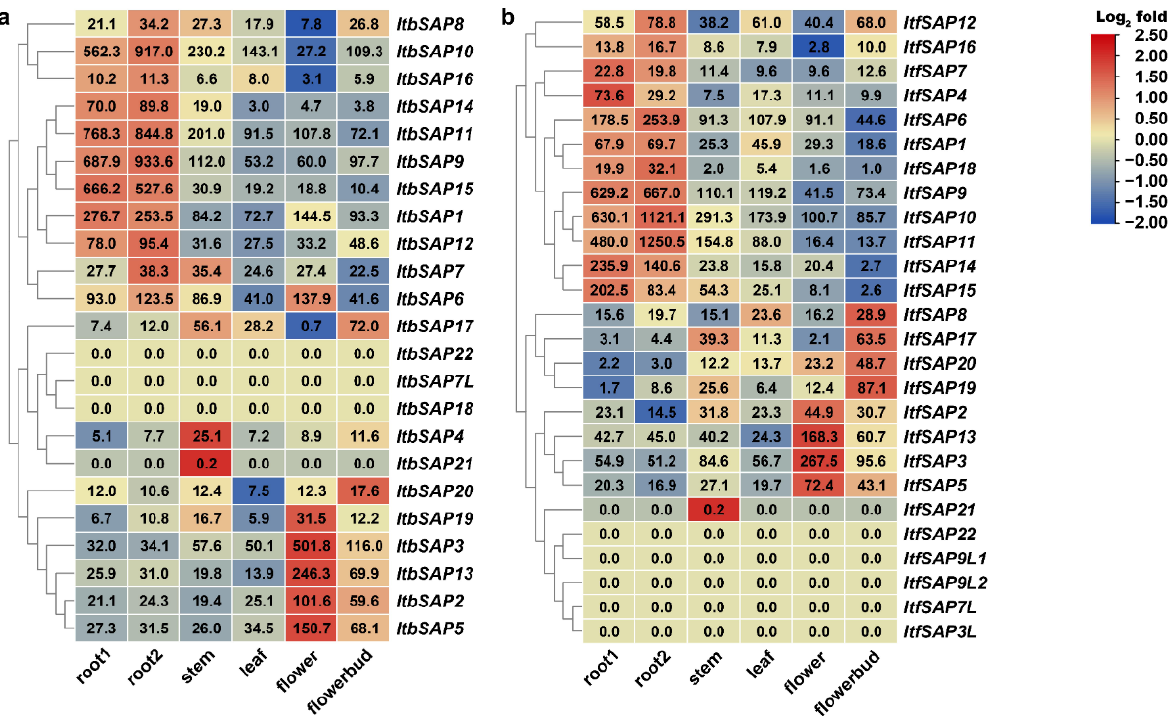
Figure 6. Expression patterns of IbSAP genes in response to salinity, drought, and ABA treatment. Sweetpotato shoots were treated with 100 mmol·L − 1 NaCl, 15% polyethylene glycol (PEG), or 10 μ mol·L − 1 ABA, and the mRNA levels were quantified by RT-qPCR and normalized using the 2 −ΔΔ Ct method. IbARF (JX177359) was used as an internal reference.